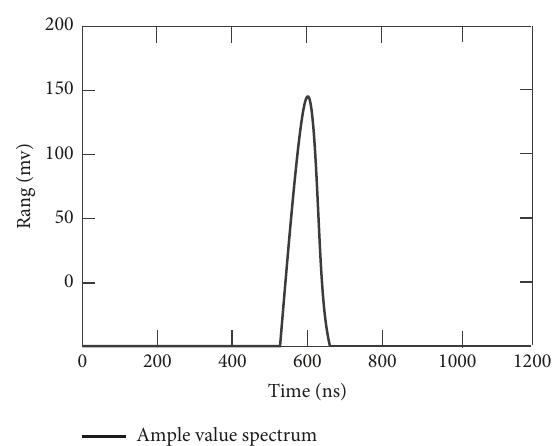
Figure 3: Amplitude